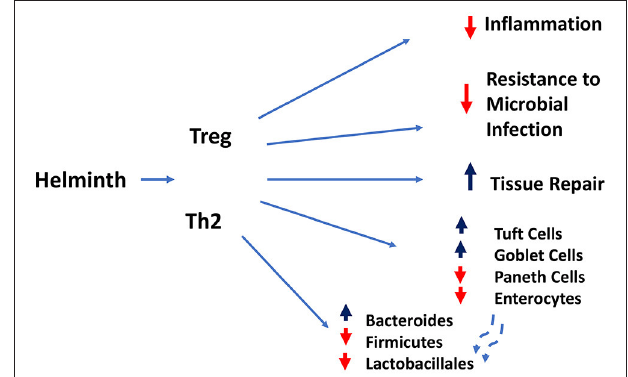
FIGURE 2 | Regulatory and type 2 immune responses (mediated by T lymphocytes and other cell types) induced by helminth infection mediate dampening of inflammatory responses and compromise resistance to microbial infection, while increasing goblet and tuft cell hyperplasia and intestinal tissue